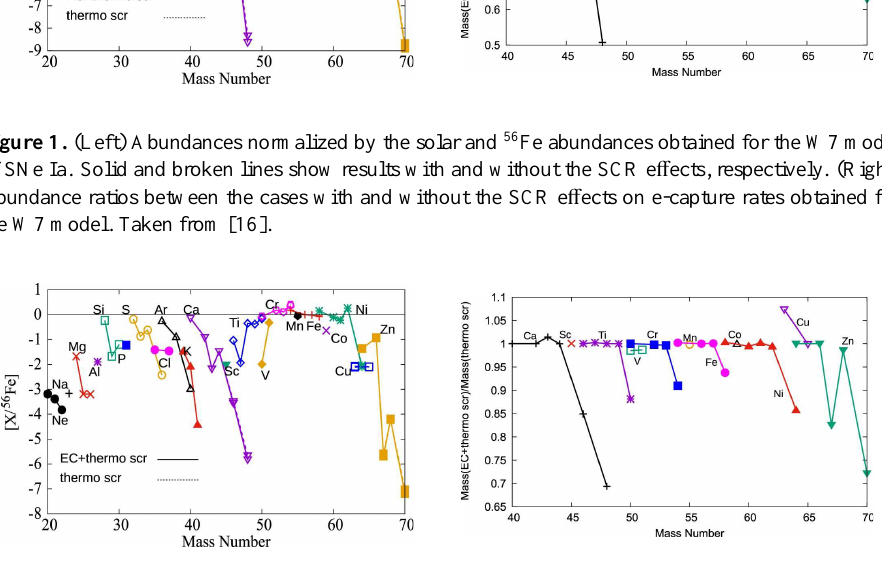
Figure 2. The same as in figure 1 for the WDD2 model of SNe Ia. Taken from